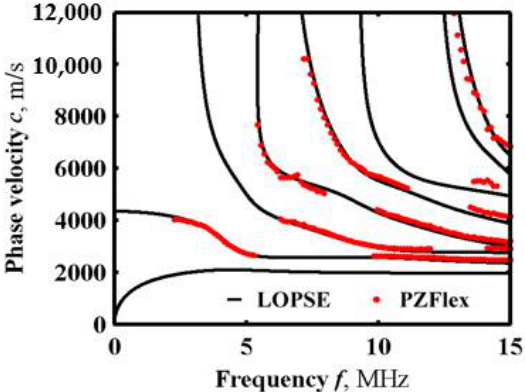
Figure 10. Comparison of simulation results with theoretical results.